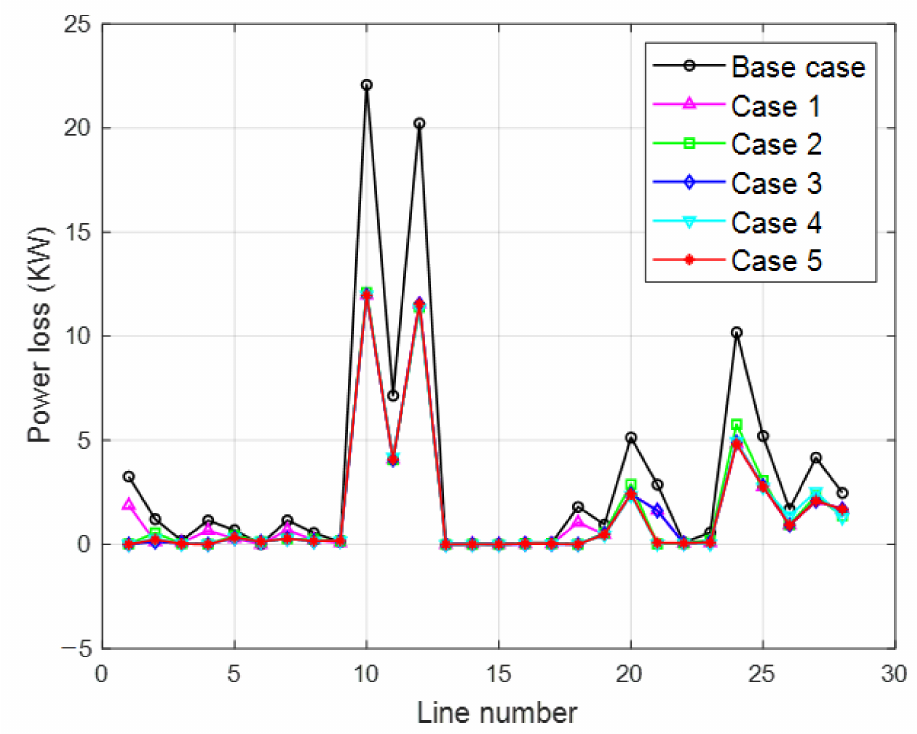
Figure 12. Power losses at each line for different cases of the